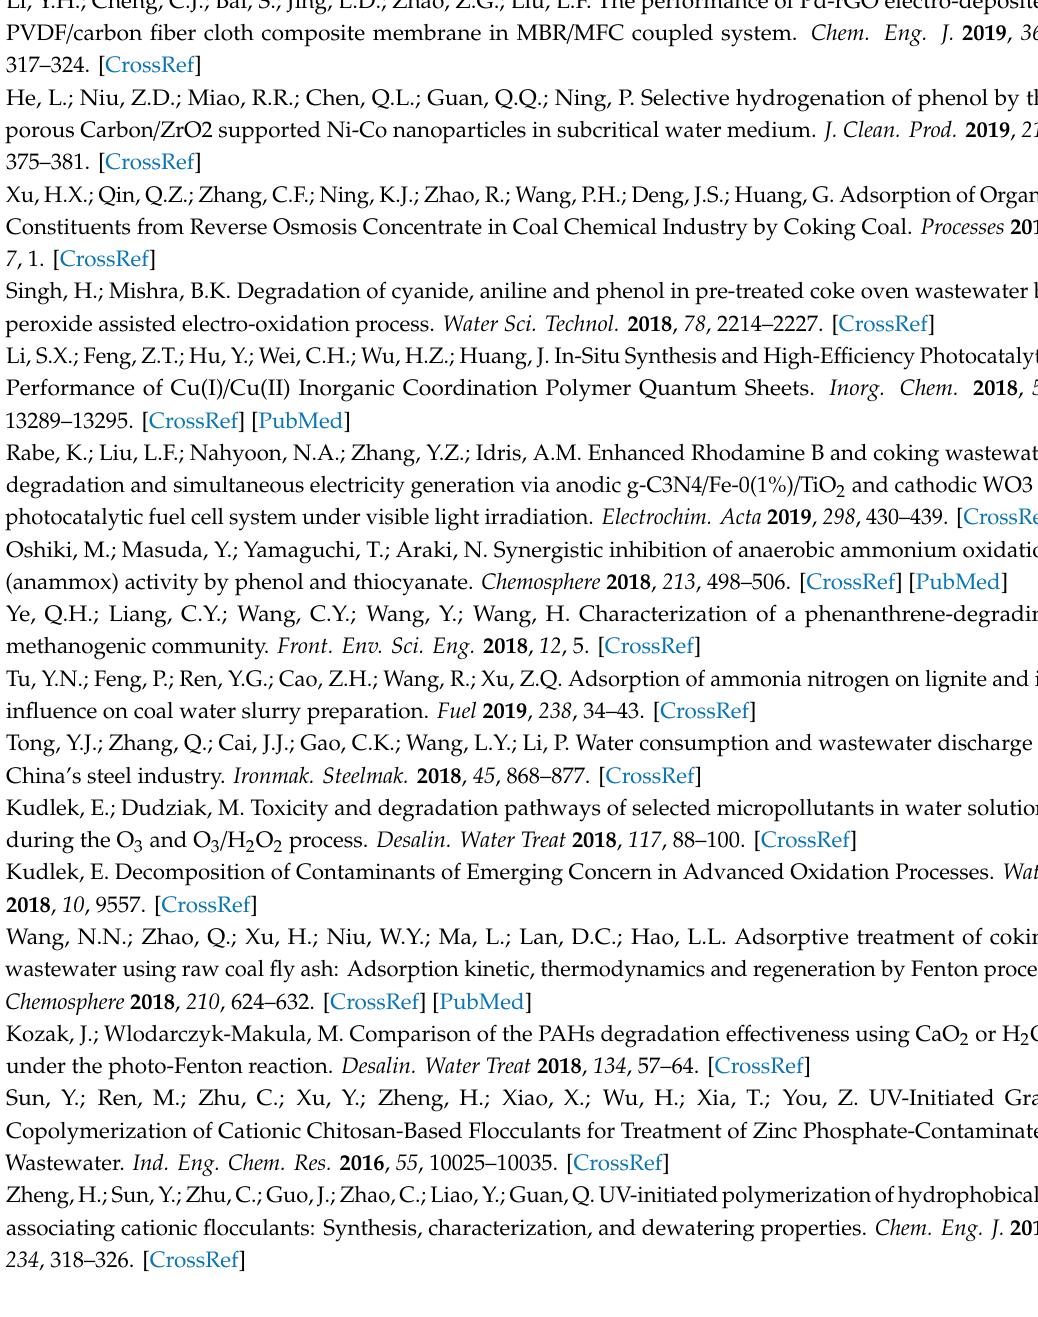
Figure S1: GC–MS diagram of e ffl uent from di ff erent processes: (a) raw water; (b) coagulation; (c) coagulation + O3 catalytic oxidation; (d) coagulation + O3 catalytic oxidation with addition of